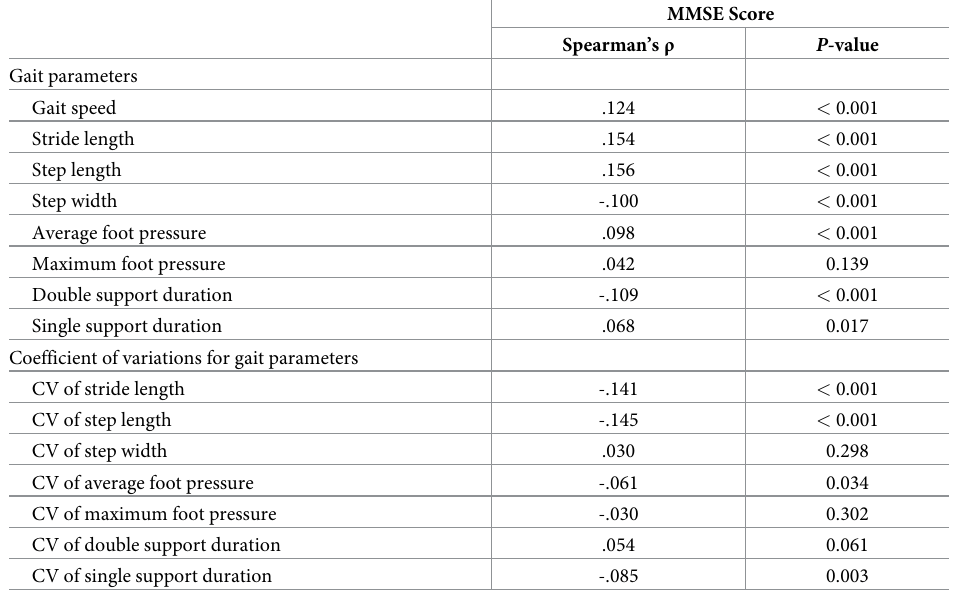
Table 2. Correlation of gait parameters with cognitive function in community-dwelling older adults.